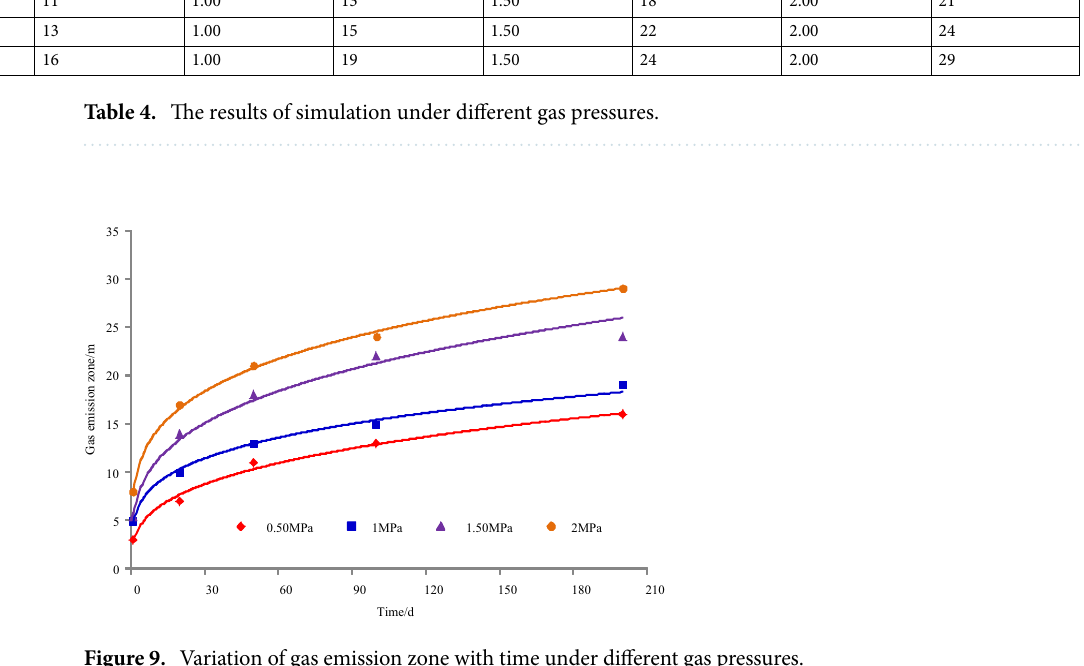
Figure 9. Variation of gas emission zone with time under different gas